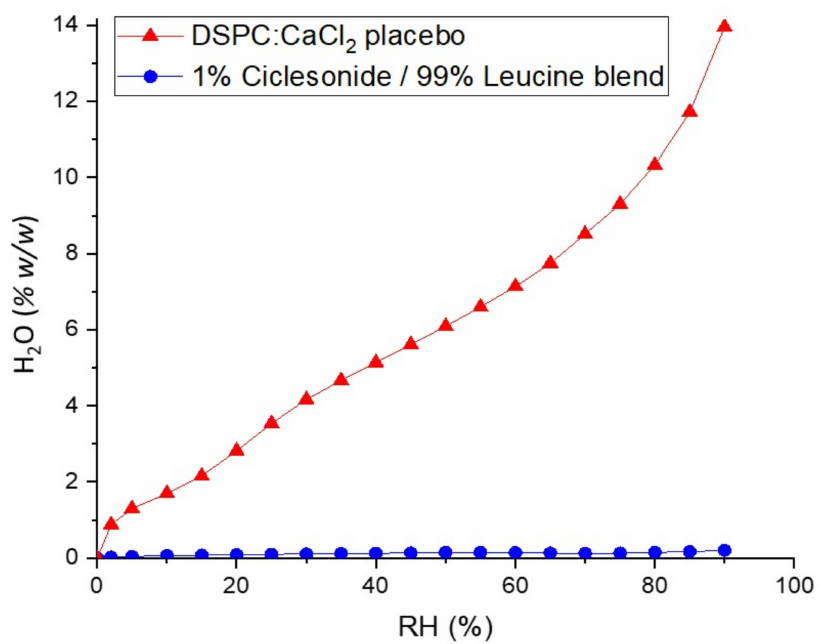
Figure 5. Moisture sorption isotherm (25 ◦ C) of 1% w / w CPI in comparison with that of the standard PulmoSphere excipients comprising a 2:1 molar ratio of DSPC to calcium chloride.